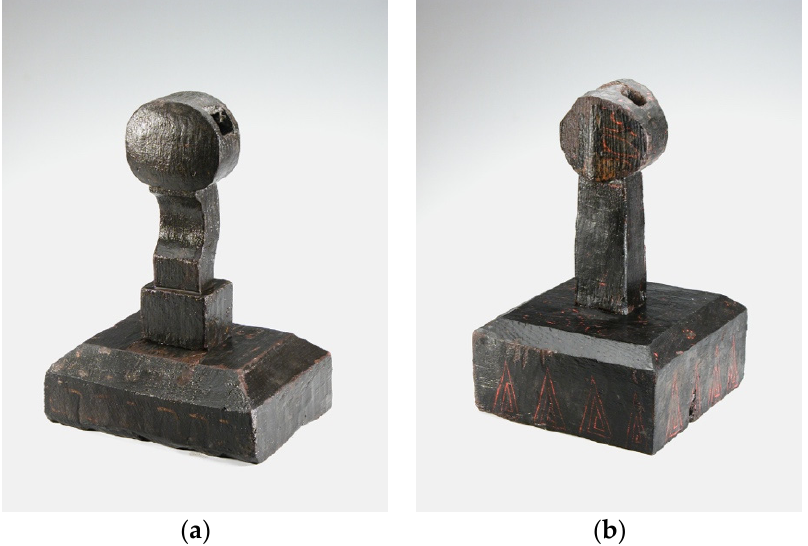
Figure 5. ( a ) Lacquered wood antlered sculpture from Tomb 124; ( b ) lacquered wood antlered sculp- ture from Tomb 101. Both excavated at Yugang, Xiangyang, Hubei. Note the sockets for antlers. From Xiangyang shi wenwu kaogu yanjiusuo (2011b, color plates 45.3 and 45.4). Another sculpture with a square base but of slightly different typology highlights the